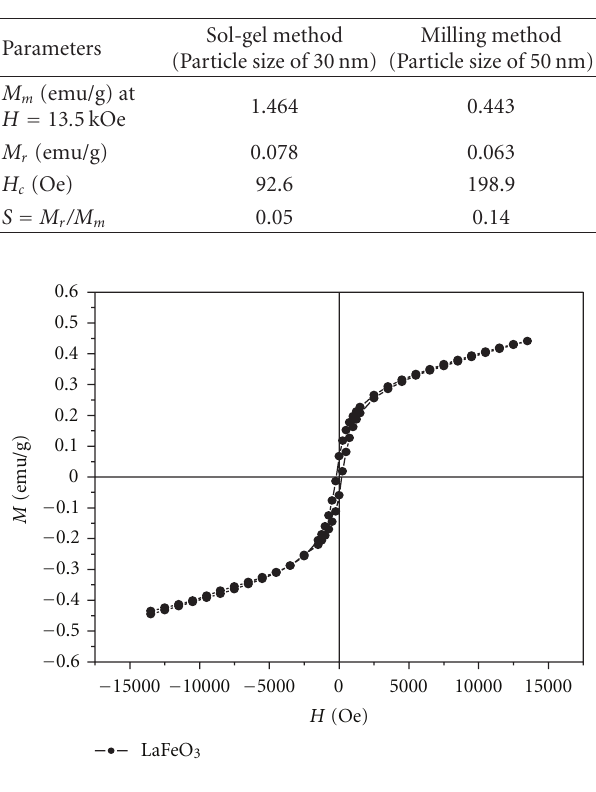
Table 1: The parameters of hysteresis loop of the samples prepared by sol-gel and milling methods.